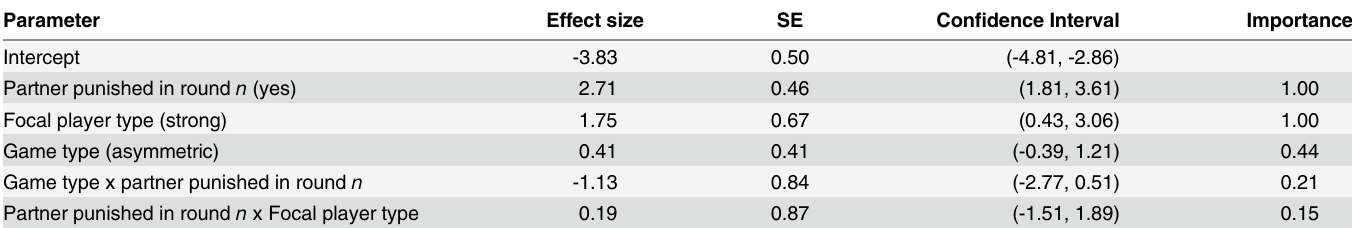
Table 6. Factors affecting whether players retaliated against punishers.